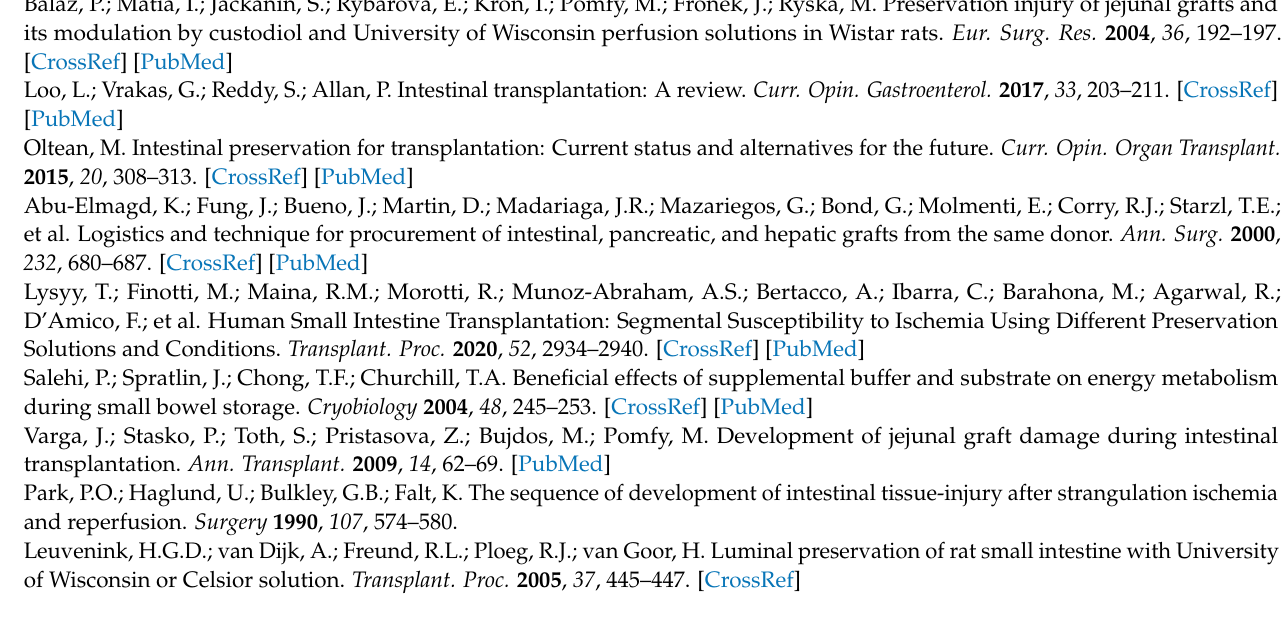
preservation. Figure S2: Impact of autophagy regulation on the expression of LC3II, Beclin-1, and caspase-3 proteins. Figure S3: Influence of autophagy regulation on cold ischemia and reperfusion mucosa